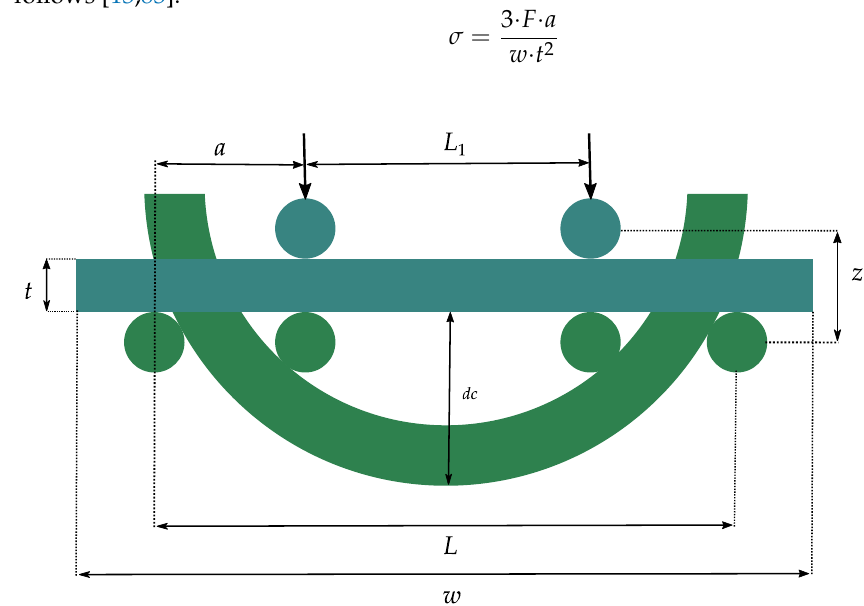
Figure 8. Diagram of a four-point bending setup before and after the bending.